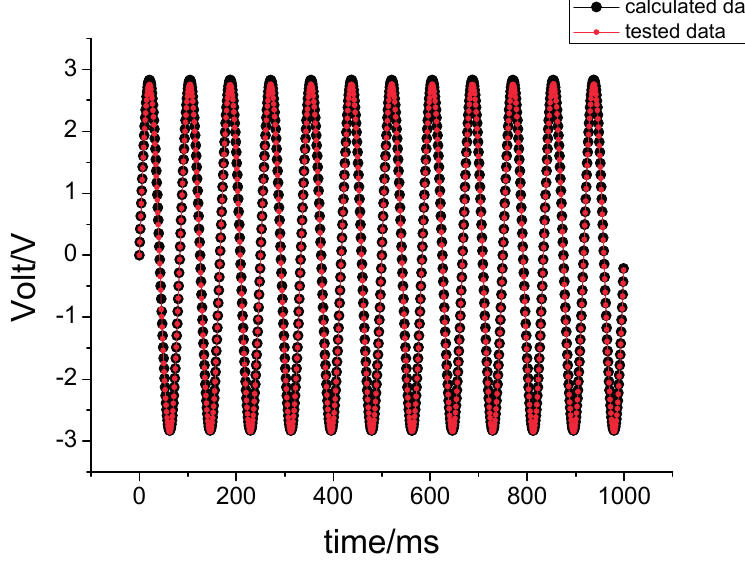
Figure 10. The experimental results when 180°/s is entered on the yawing